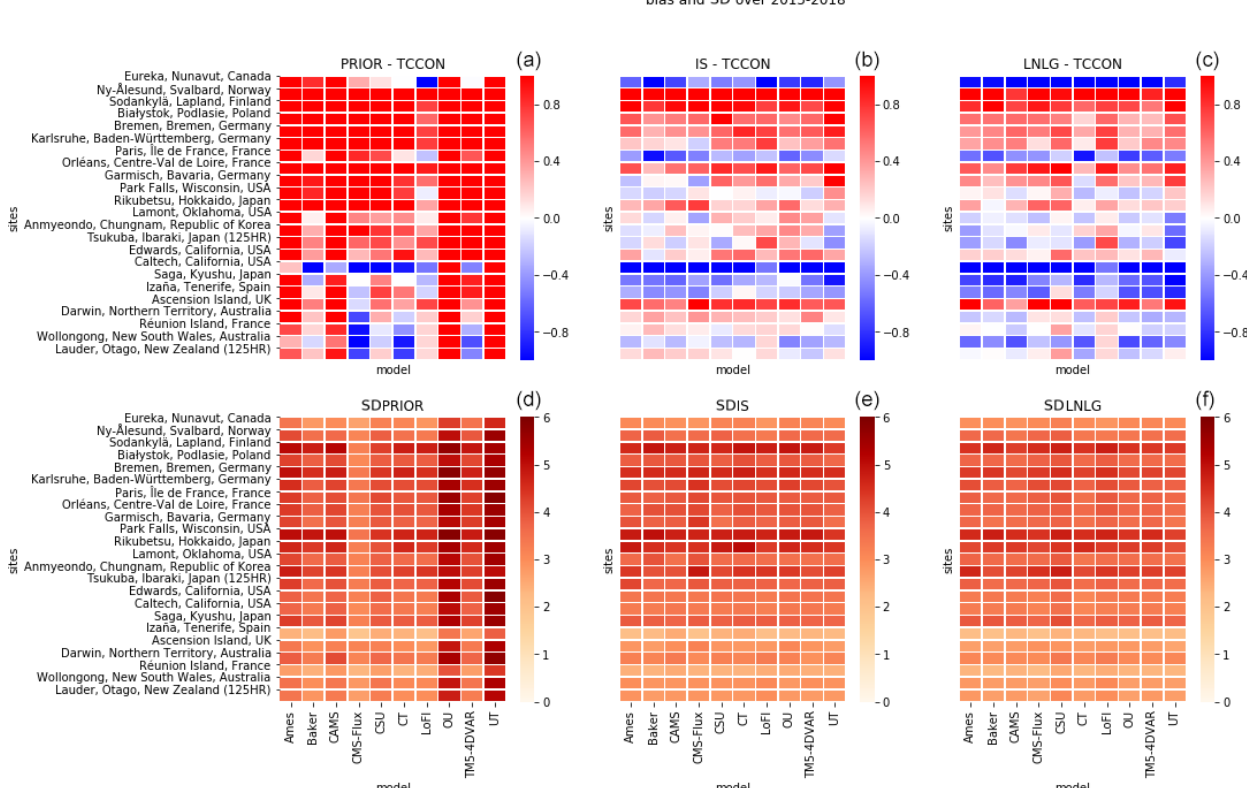
Figure 17. Comparison between TCCON data and the MIP ensemble for the IS and LNLG experiments. Panels (a–c) show experiments biases and (d–f) show standard deviation compared to TCCON sites. Biases and standard deviation are expressed in ppm CO 2 . Priors are in (a, d) , IS in (b, e) , and LNLG in (c, f)